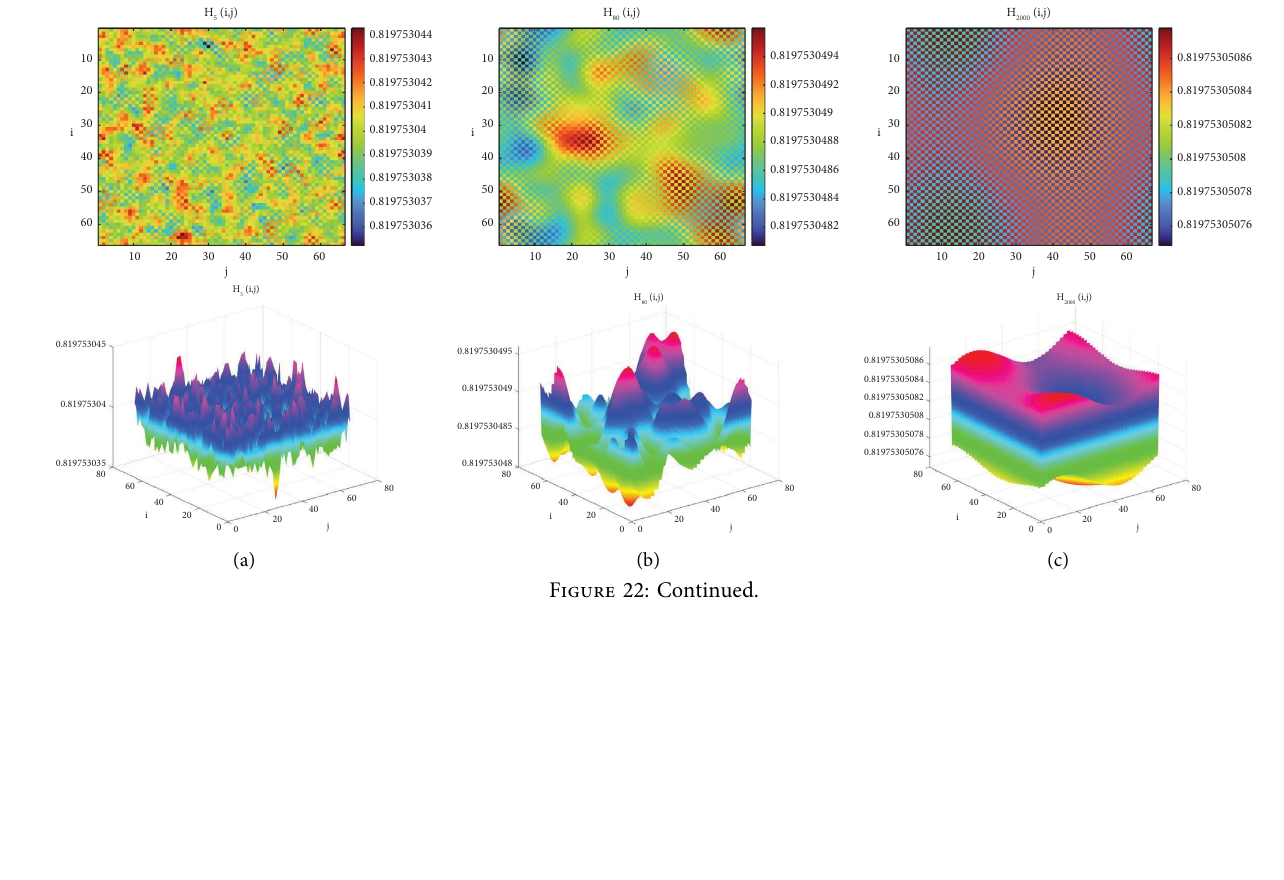
, d ) � ( 0 . 1 , 0 . 1 ) falls in the region III of Figure 9(b), which is consistent with 1 2